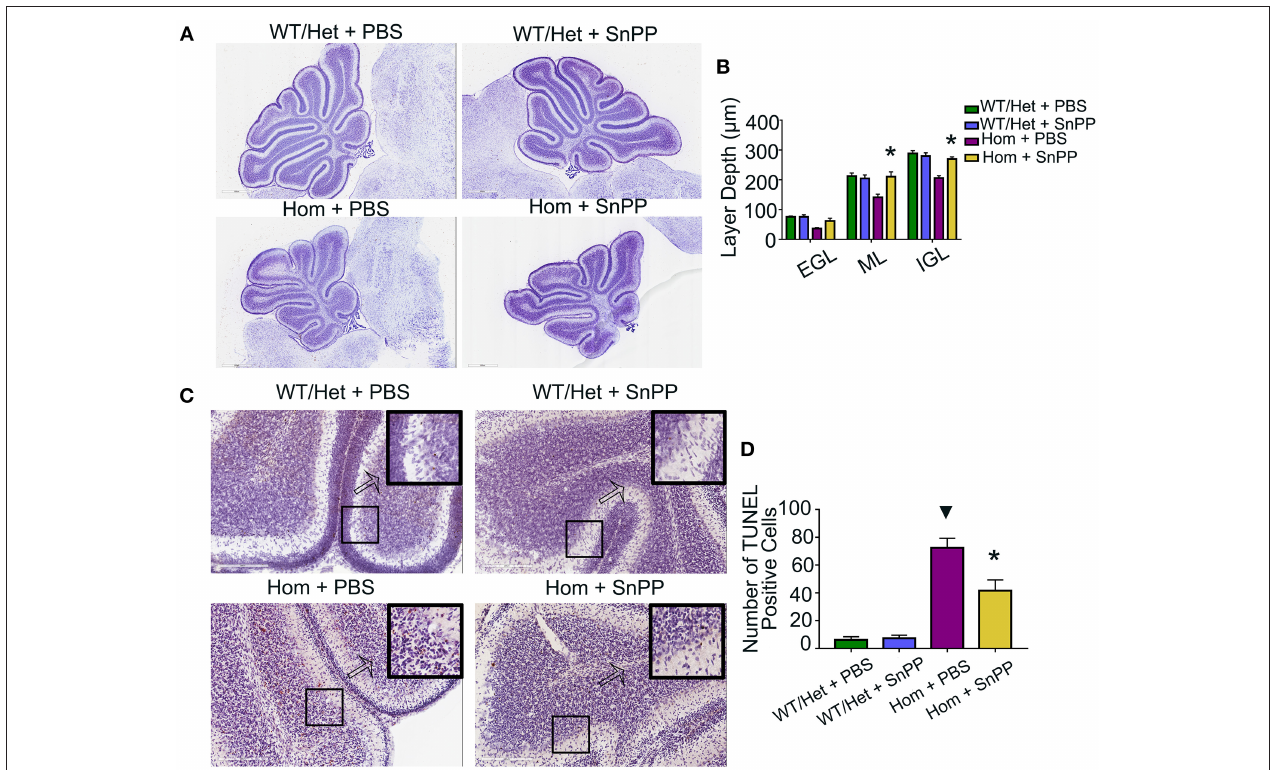
FIGURE 3 | SnPP treatment improves cerebellum development and reduces apoptosis of cerebellum cells. (A) Representative images of Nissl staining of Ugt1 WT/Het and Hom mice cerebellum which were received SnPP (20 mg/kg P8 and 30 mg/kg P9) or equivalent volume of PBS. Scale bar = 600 µ m. (B) One-way ANOVA analysis was conducted among four groups of mice at every layer depth of lobule 4 and lobule 9 ( n = 4–6, respectively). Two days of SnPP treatment increased Ugt1 − / − mice the ML depth and IGL depth of cerebellum when compared with Hom + PBS mice. (C,D) Left panel, representative TUNEL images on the cerebellum frozen section at P10. Scale bar = 200 µ m. Right panel, TUNEL positive cells were counted ( n = 3–4, respectively). H represented P value comparing between Hom + PBS group and WT/Het + PBS group ( P < 0.05), *represented P value comparing between Hom + SnPP group and Hom + PBS group ( P < 0.05). EGL, external granular layer; ML, molecular layer; IGL, internal granular